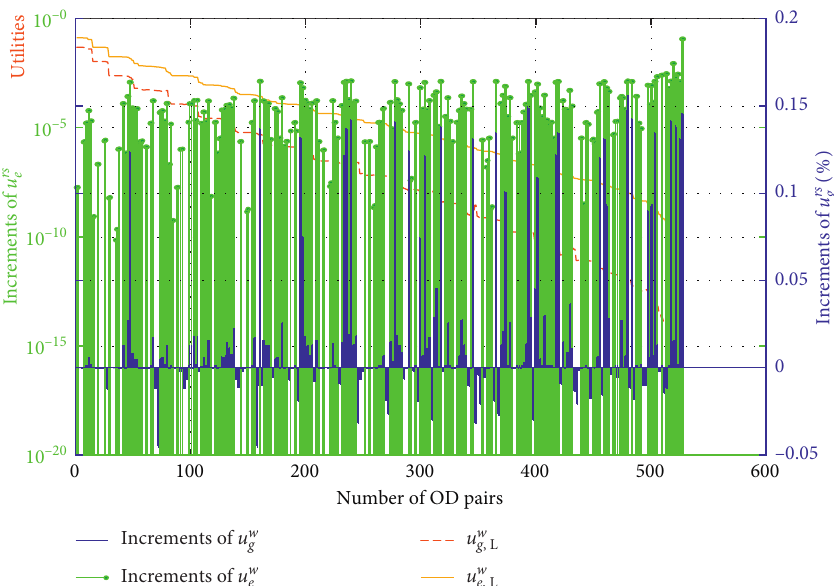
Figure 4: Utilities of 528 OD pairs of Sioux-Falls network with/without distance